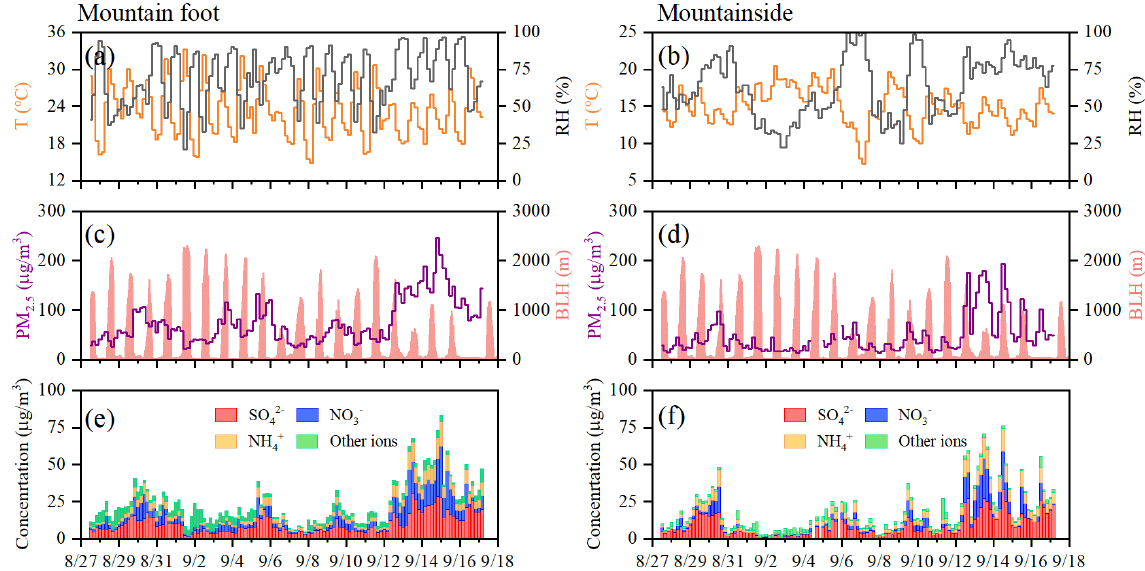
Figure 2. Time series of the temperature ( T ), relative humidity (RH), boundary layer height (BLH), and mass concentrations of PM 2 . 5 and the water-soluble ions in PM 2 . 5 during the observation period at the two sampling